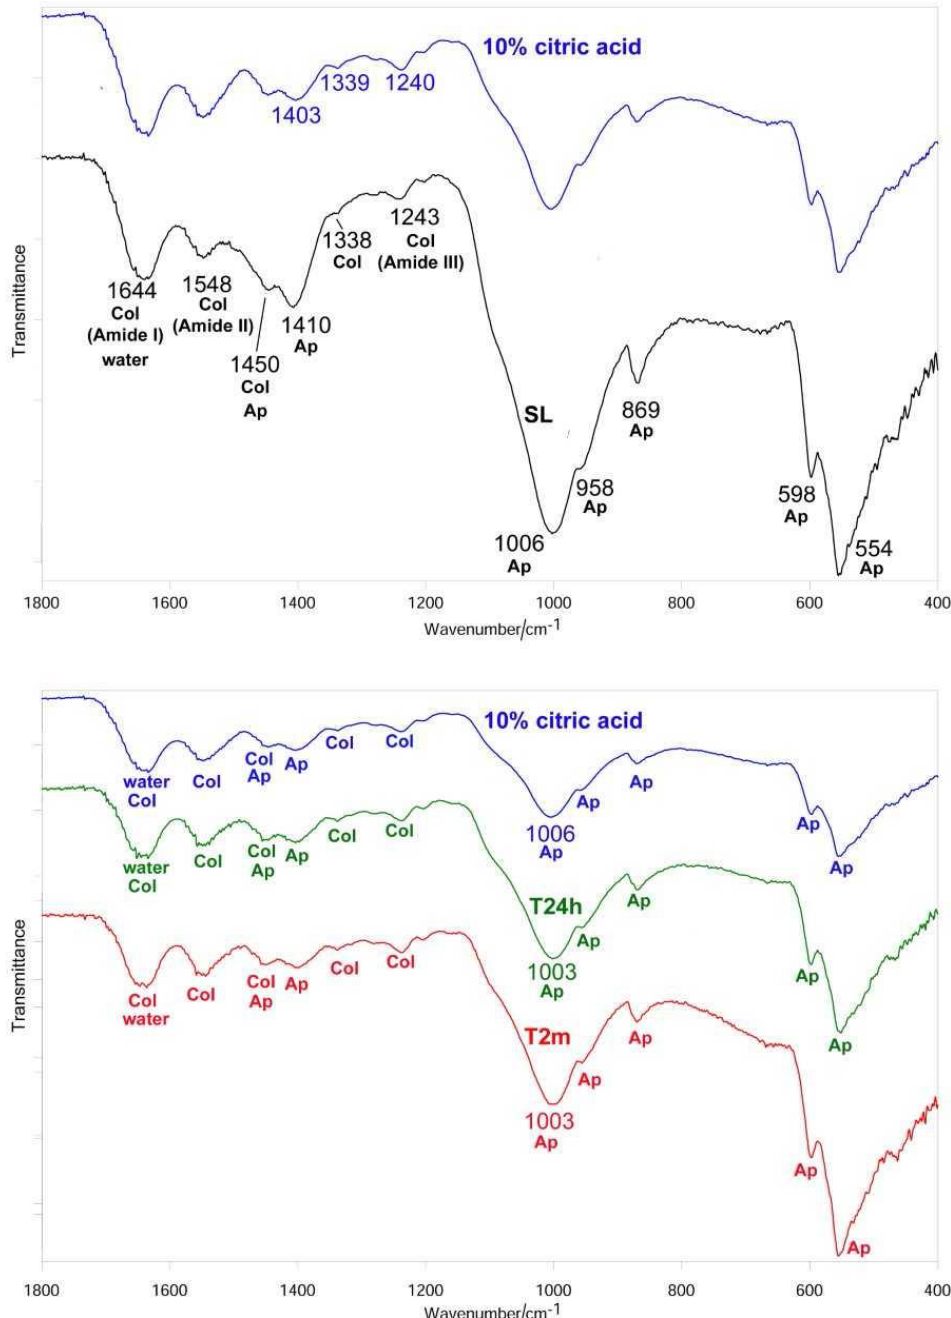
Figure 9. Average IR spectra recorded on the dentin surface after sanding (SL, black), treatment with 10% citric acid solution (blue), aging in SBF for 24 h (T24h, green) and two months (T2m, red). The bands prevalently assignable to collagen (Col), water, and B-type carbonated apatite (Ap) are indicated.